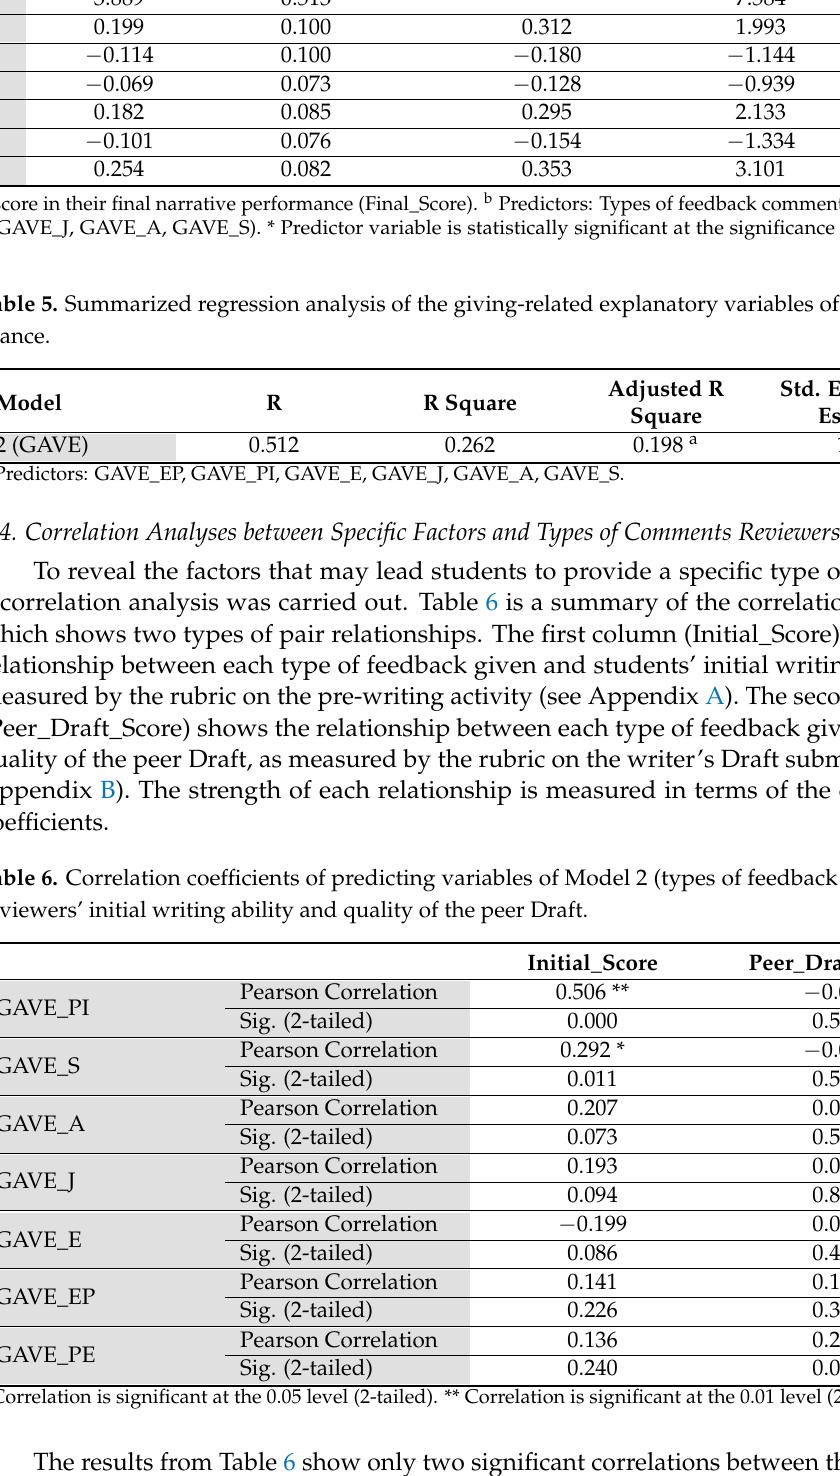
Table 4. Multiple regression analysis predicting students’ performance in the Final Version of the writing assignment. Model